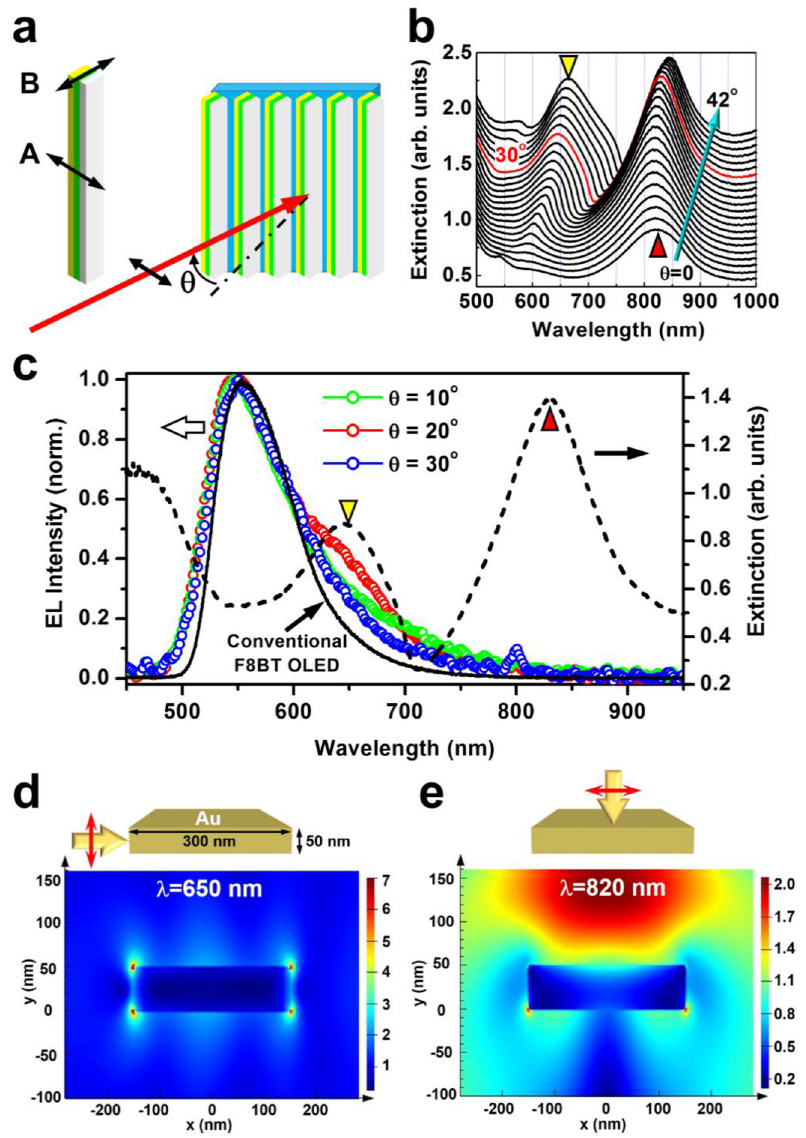
F8BT OLED on a planar unstructured substrate. Dashed curve: optical extinction spectrum at θ = 30 ° . (d) Simulation of the opticalelectric fi eldinagoldnanostripwith a width of about 300 nm and a thickness of 50 nm for excitation at 650 and 820